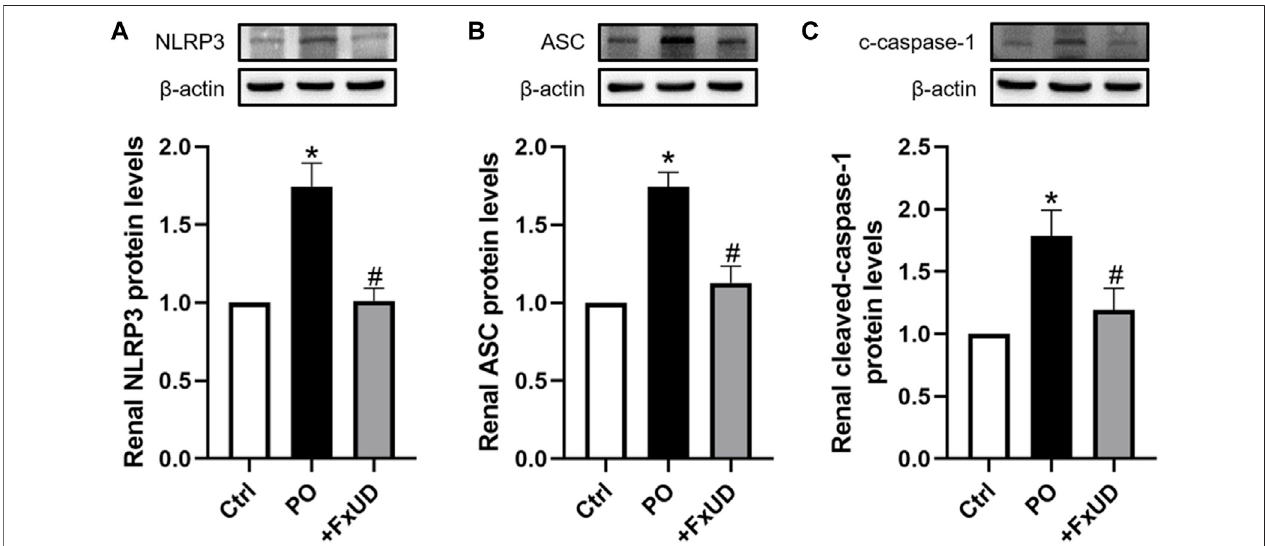
FIGURE6| FxUDinhibitstheactivationofNLRP3in fl ammasomeinthekidneyofmicewithhyperuricemia.Graphicrepresentationsoftheratios (A) NLRP3/ β -actin, (B) ASC/ β -actin and (C) c-caspase-1/ β -actin. β -actin was used as loading control. Values are expressed as the means ± SD ( n (cid:1) 5). * p < 0.05 vs. Ctrl, # p < 0.05 vs. PO.